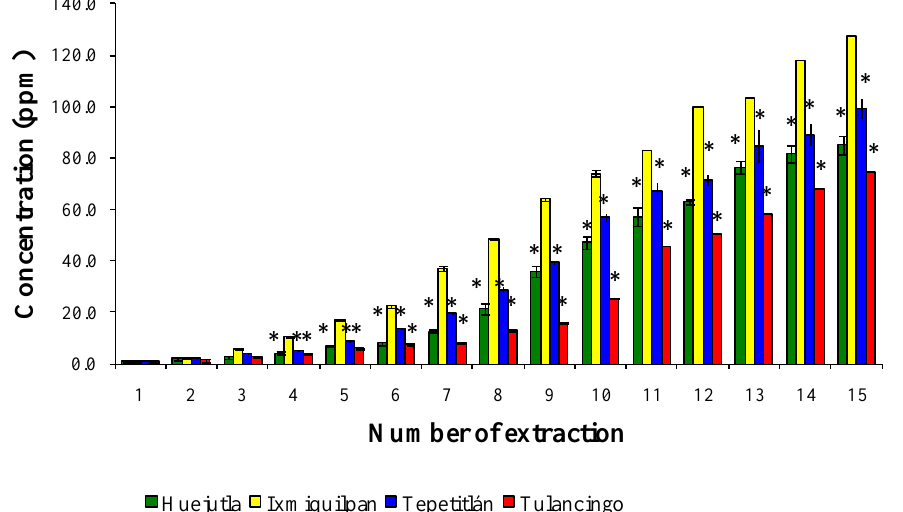
Figure 7. Concentration of leached Cd from the glass-clay containers into acetic acid. The bars show the mean values of the four regions studied, along with their standard deviations. * Indicates significant statistical differences with respect to the Ixmiquilpan region, which represents the highest concentration of the metal; p ≤ 0.05.